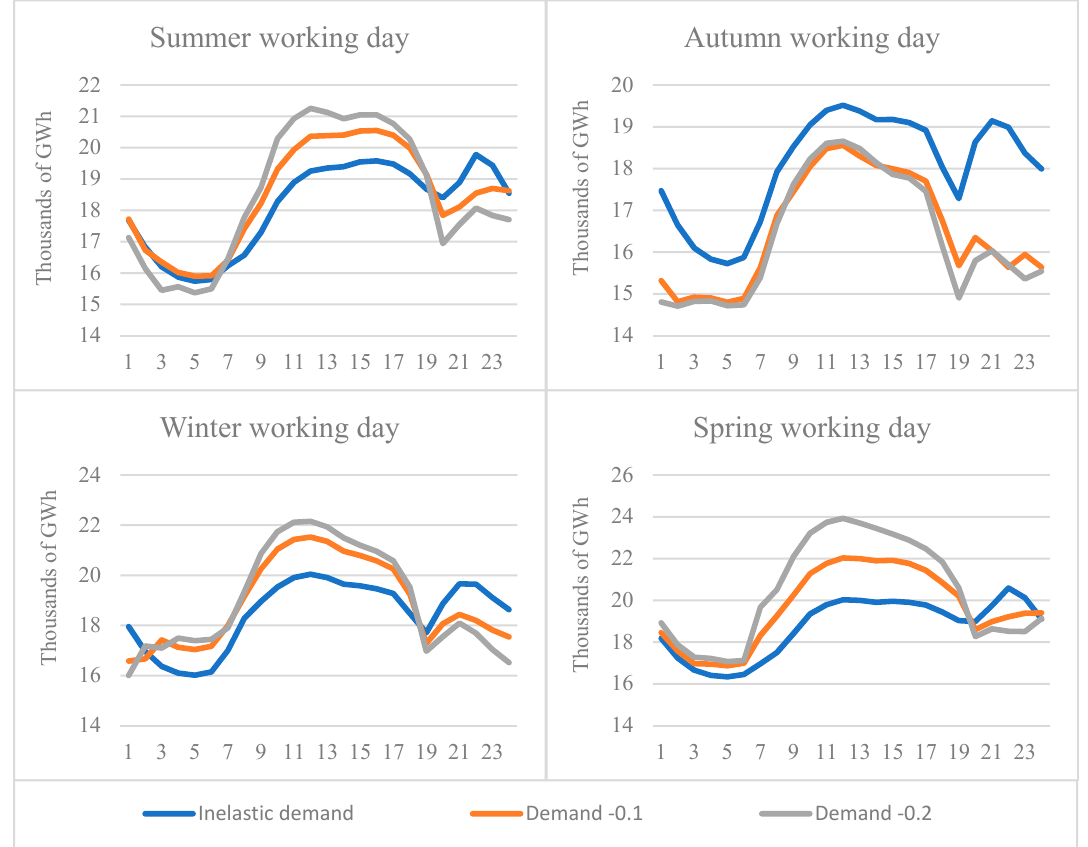
Figure 11. Demand curves for the different levels of elasticity.